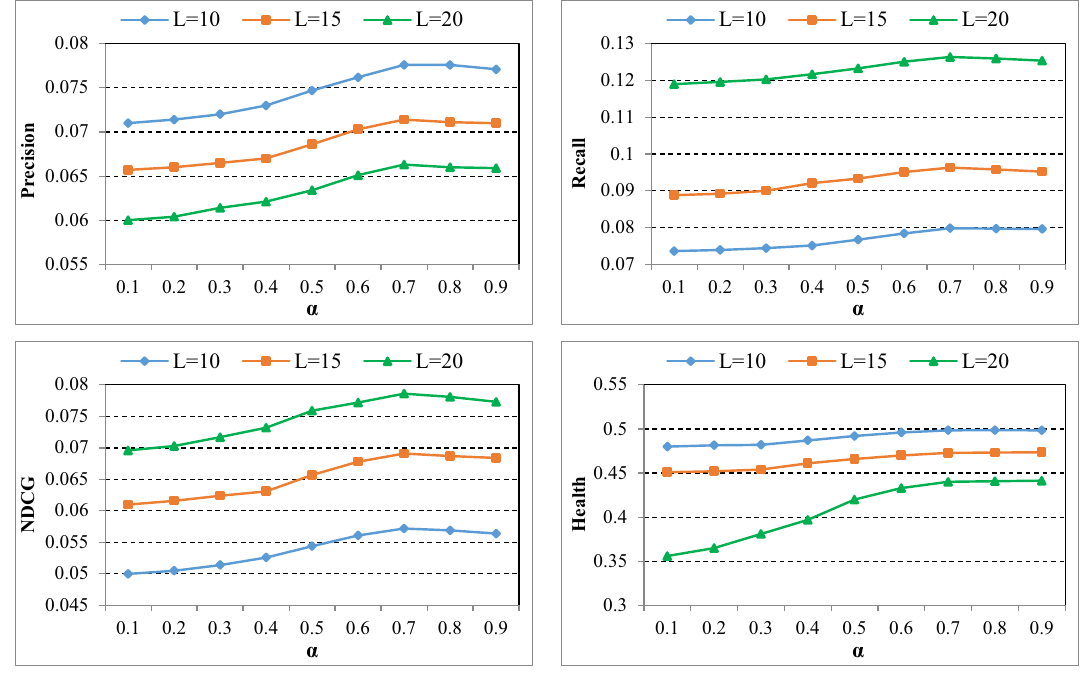
Fig. 4 Experimental results regarding the sensitivity analysis of the parameter 𝛼